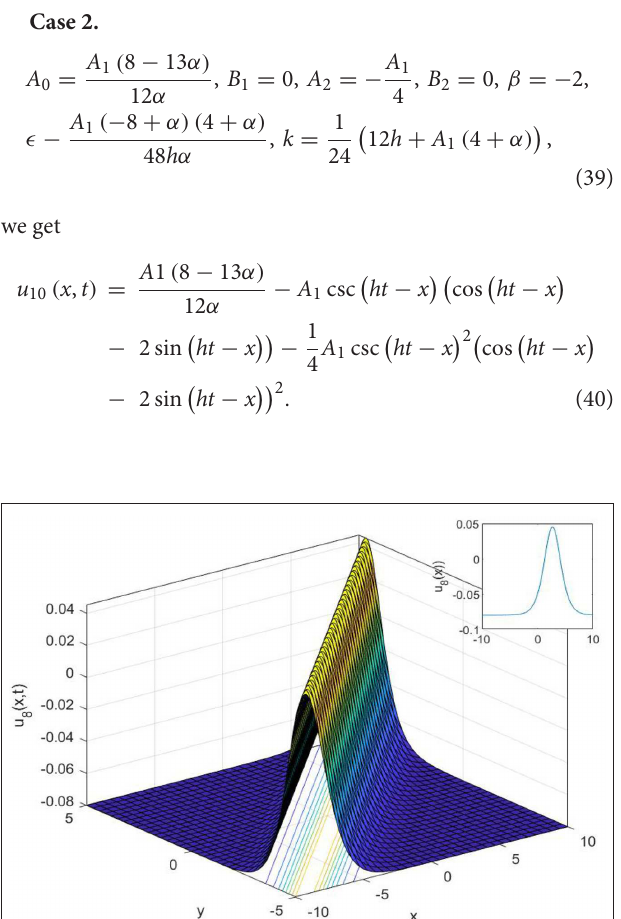
FIGURE 8 | The 3D, 2D, and contour surfaces of Equation (35) using k 0.5, α 25, and h = = =